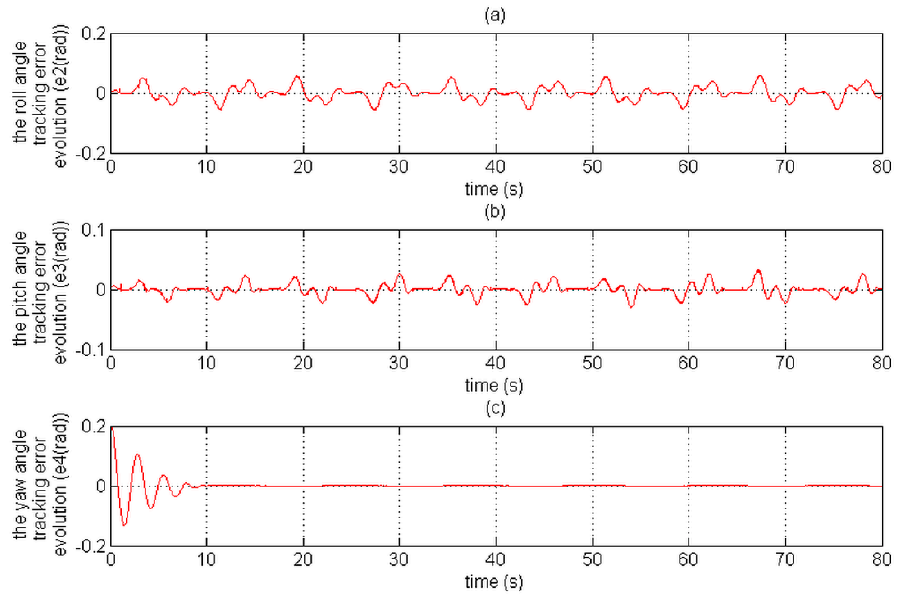
Figure 18. The attitude tracking errors obtained by the CMTC: ( a ) roll angle error e 2 ( rad ) ; ( b ) pitch angle error e 3 ( rad ) ; ( c ) yaw angle error e 4 ( rad )